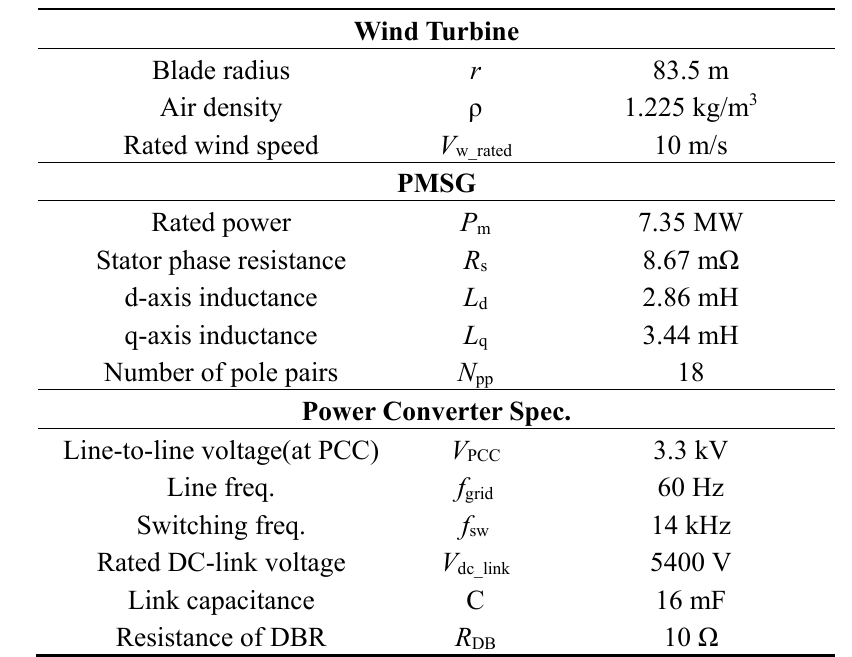
Table 1. Simulation